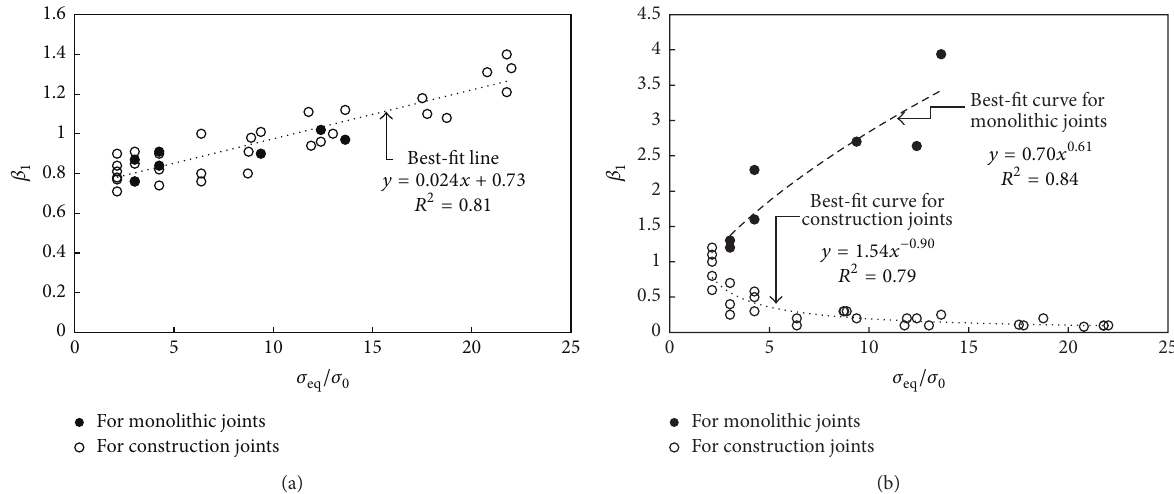
Figure 4: Regression analysis for 𝛽 1 determined from the empirical fitting approach using (3) and push-off test data: (a) ascending branch; (b) descending